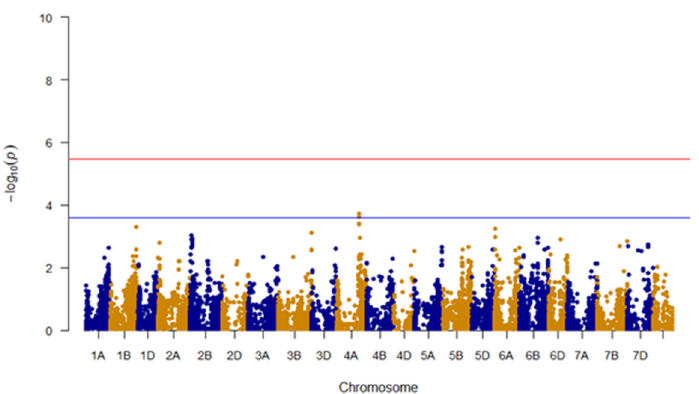
Figure 6. Manhattan plot showing trait associated SNPs for water retention capacity; Un, unanchored scaffold; red line, Bonferroni correction (adjusted p < 0.05) cutoff; blue line, notable SNPs above the background.